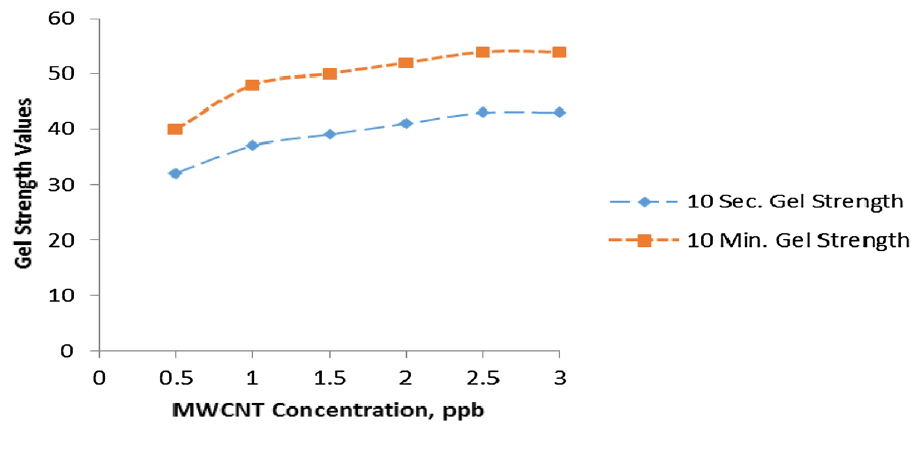
Fig. 4 Gel strength at different concentrations of MWCNT for OBM